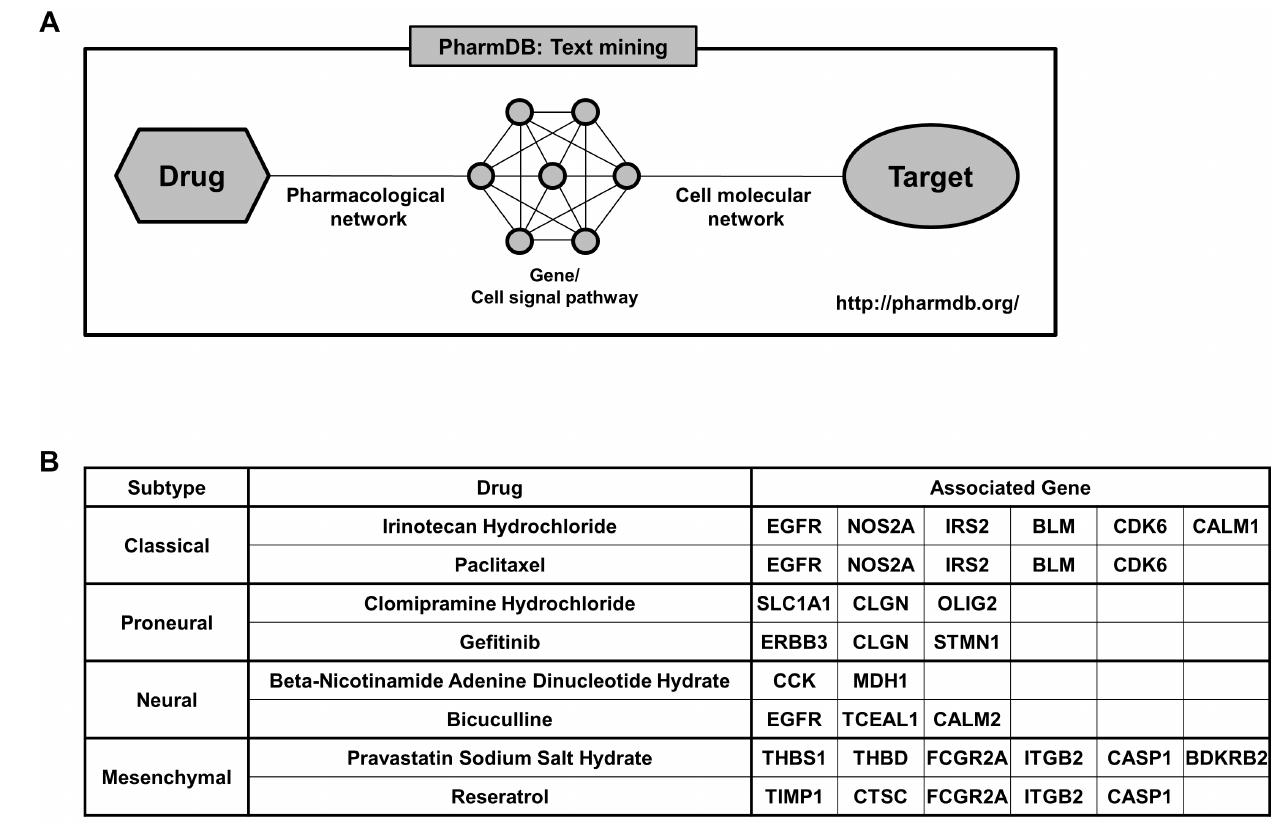
Figure 5. Schematization of PharmDB text mining system. ( A ) Working scheme of PharmDB that matches target genes with appropriate therapeutic agent candidates based on text mining technologies. ( B ) Subtype specific drugs and its target genes.